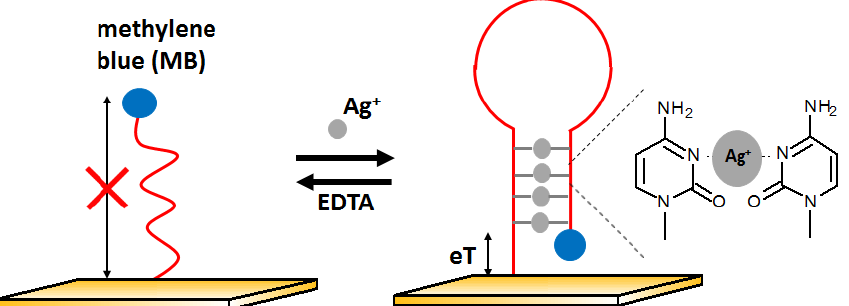
Figure 15. Oligonucleotide-based electrochemical biosensor in the receptor layer before ( left ) and after ( right ) adding silver ions.